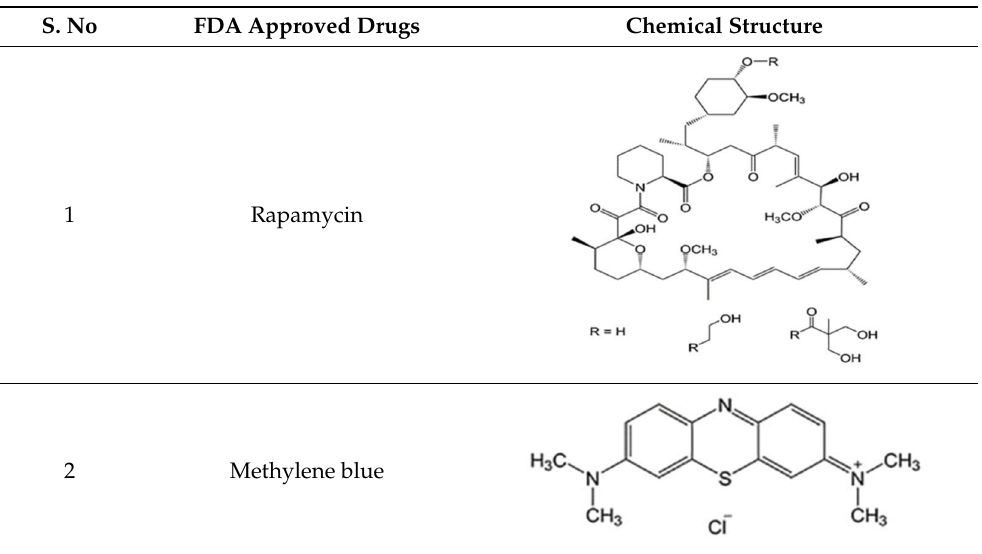
Table 2. Illustrates the chemical structure of the molecules and drugs, which can plausibly manage and cure HSP. The FDA approves these drugs to conduct clinical trials as they have shown positive results in animal models.